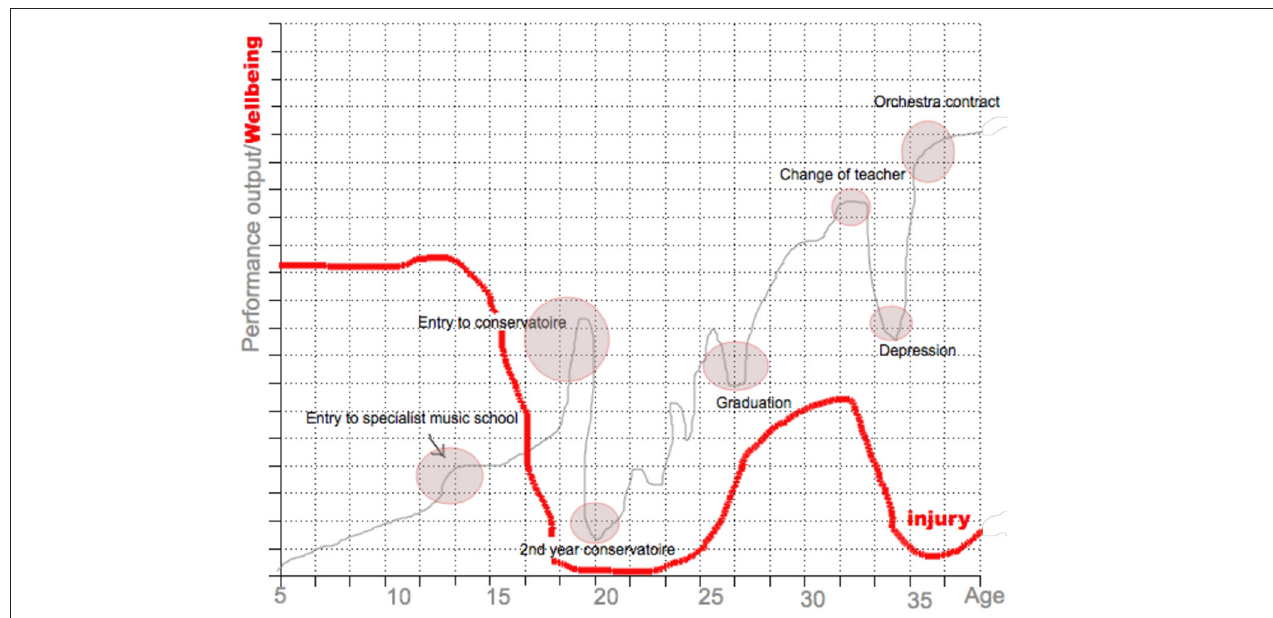
FIGURE 1 | Exemplar copy of hand-drawn graph showing performers’ perceived performance output and wellbeing over time (identifying details have been omitted).